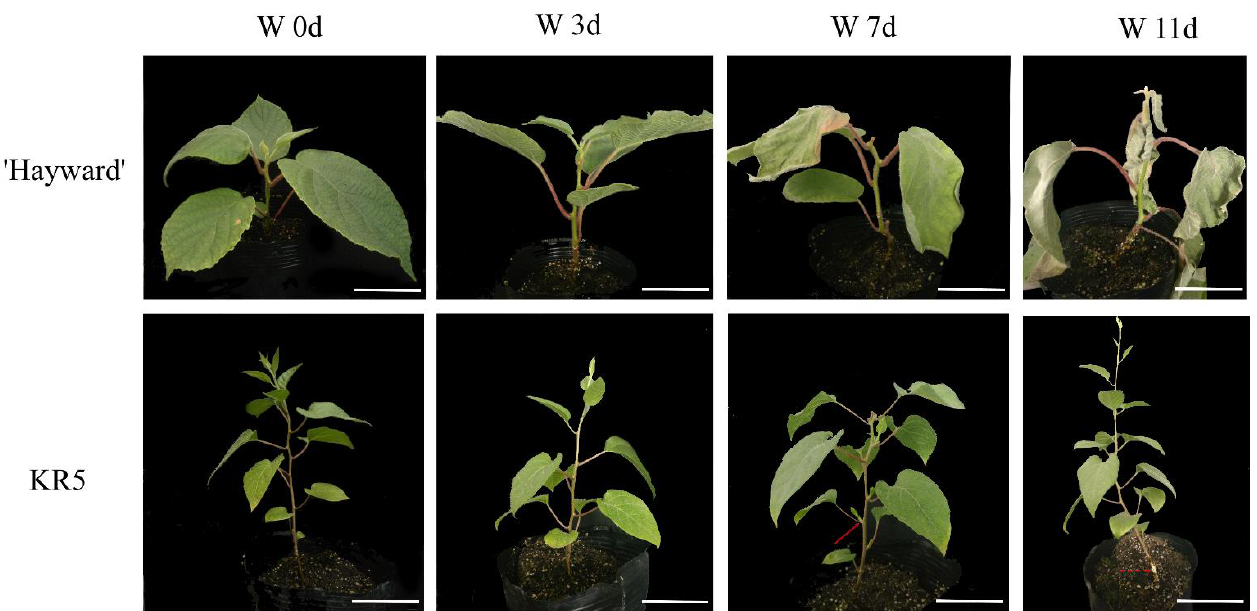
Figure 1. Morphological changes of ’ Hayward ’ and KR5 plants under waterlogging stress. W 0d, W 3d, W 7d, and W 11d indicate 0, 3, 7, and 11 d after waterlogging stress, respectively. ’Hayward’ , from Actinidia deliciosa , and KR5 from Actinidia valvata . The solid and dashed arrow shows the newly formed sprout and callus in KR5 under waterlogging stress, respectively. Bar = 10 cm.